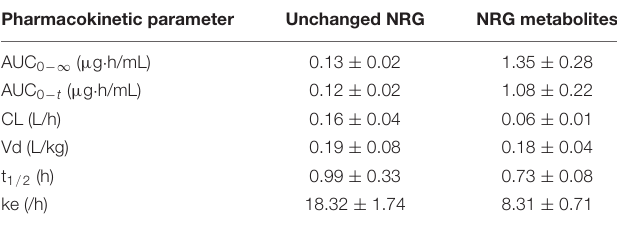
FIGURE 5 | Inhibition of acetic acid-induced writhing behavior by NRG SD. Saline (control), crystalline NRG (100 mg/kg), and NRG SD (30 or 100 mg/kg) were orally administered five min before acetic acid treatment. Cumulative numbers of abdominal contortions (writhing score) were evaluated over 25 min (means ± SE; n = 8). * p < 0.05, ** p < 0.01 (Tukey–Kramer